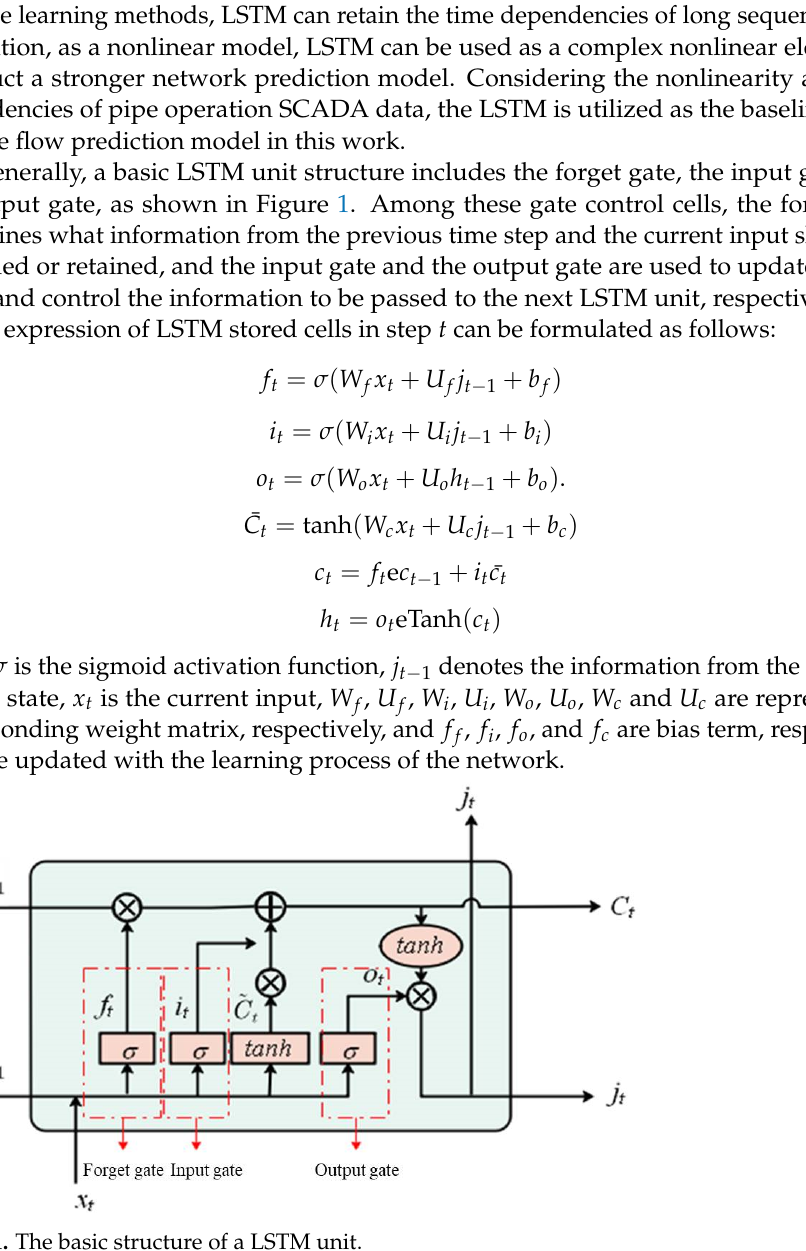
Figure 1. The basic structure of a LSTM